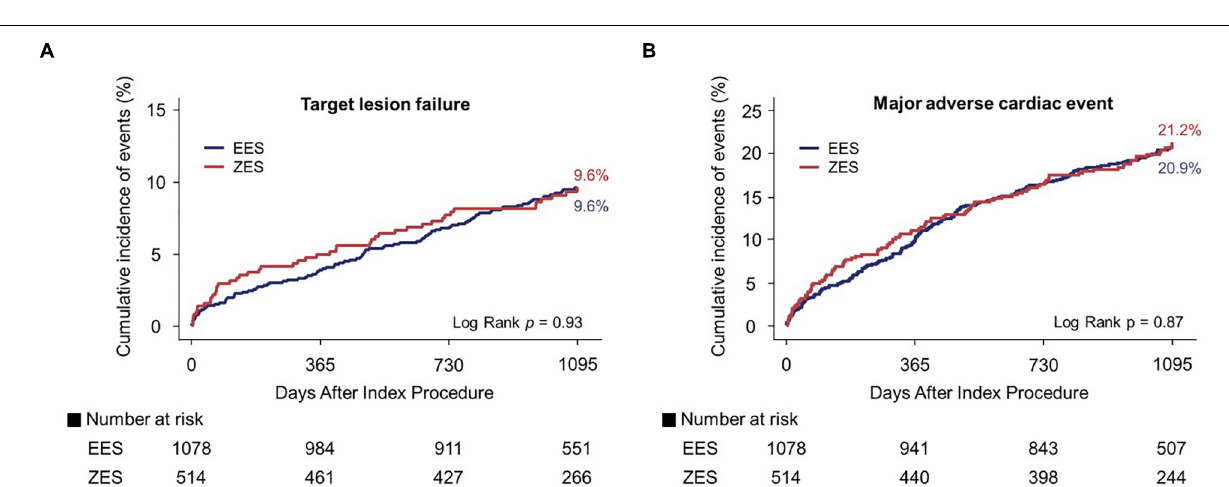
Frontiers in Cardiovascular Medicine |